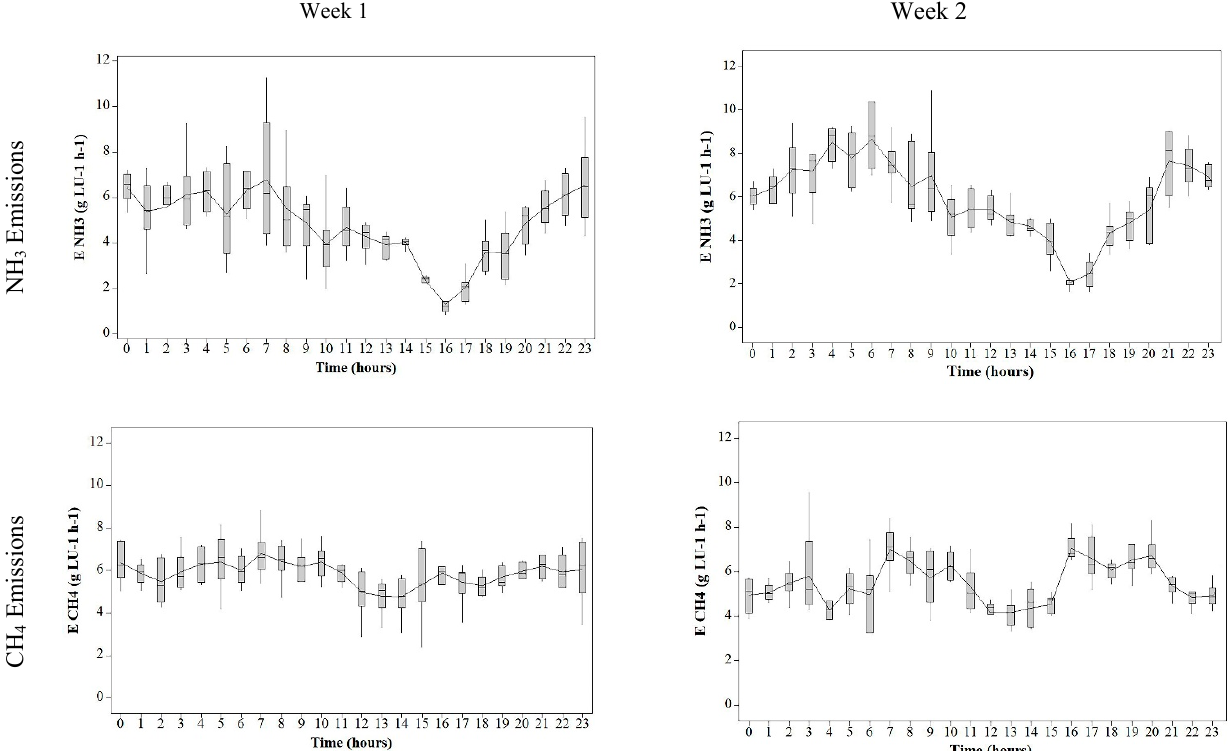
Figure 2. Daily trend of NH 3 and CH 4 emissions during W1 and W2.